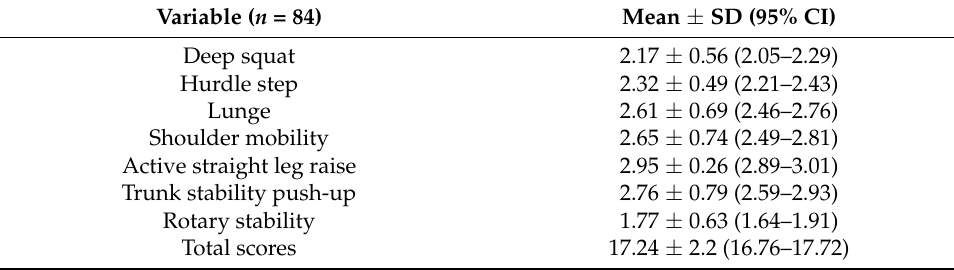
Table 2. The FMS scores for all